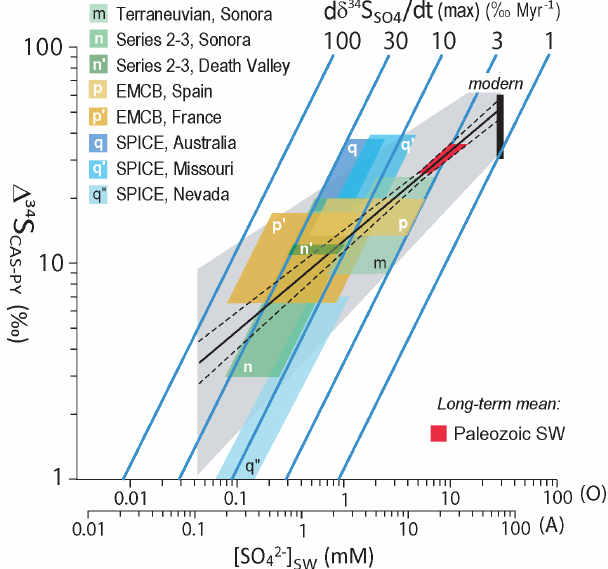
Figure 6. Analysis of seawater sulfate concentrations for 10 late Neoproterozoic marine units. The parallelogram for each unit was generated using the rate method. A summary of results and data sources is given in Table S4; other details as in Figs. 1–2.